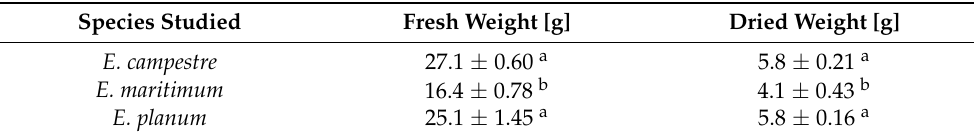
Table 2. The root biomass (g ± SE) of Eryngium spp. in MS liquid medium after 24 weeks of in vitro